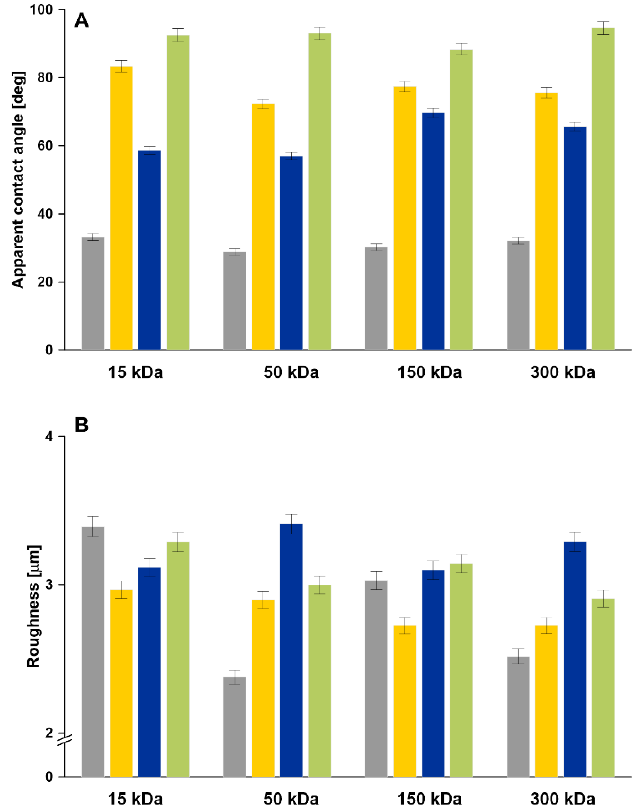
Figure 5. Differences in apparent contact angle ( A ) and roughness ( B ) of the investigated membranes: pristine samples, samples modified with silane, samples immobilized with the enzyme, and samples applied in the process.